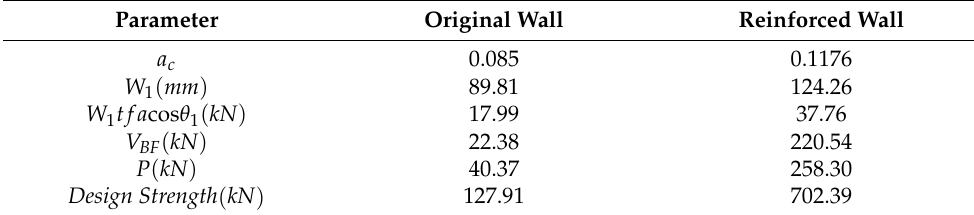
Table 3. Resistance of the brick wall. Parameter